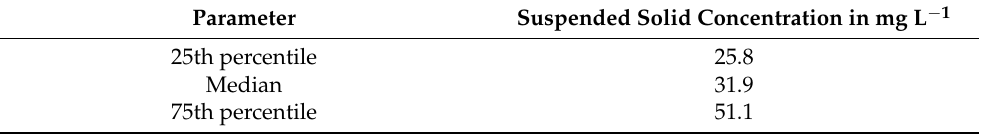
Table 2. Concentrations during dry weather in the Kraichbach river.